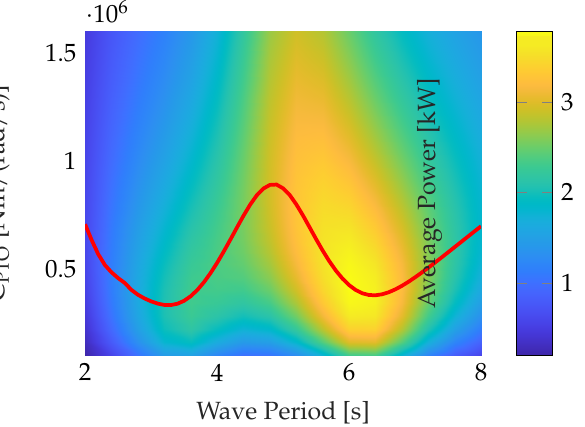
Figure 6. Heat map showing the optimal value of C PTO and the corresponding absorbed power as a function of different wave periods. Wave input: Regular with height of 0.5